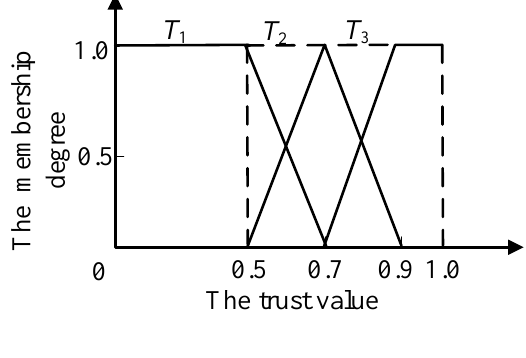
Figure 1. The membership function of node’s trust.